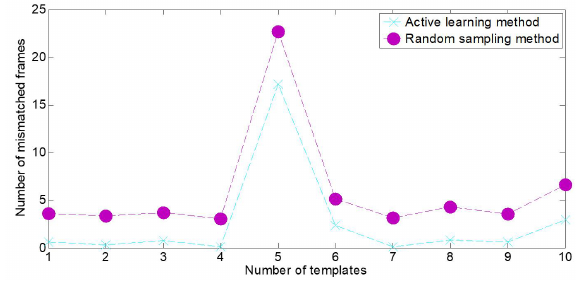
Fig. 7. Mismatch results of the two learning methods in the Dudek test